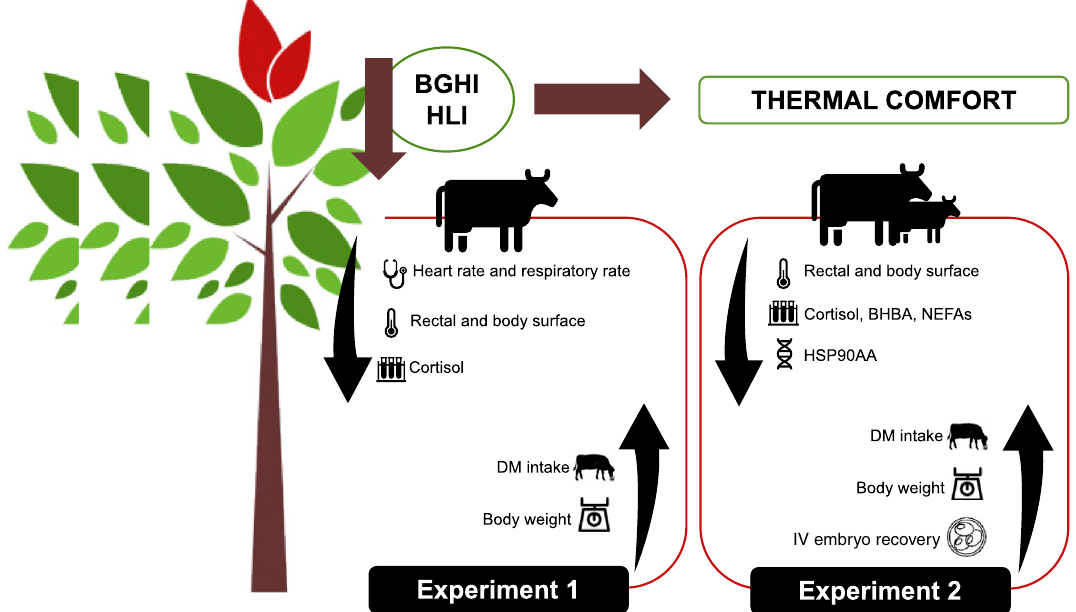
Figure 1. Hypothetical model. Natural shade in pasture areas improves the thermal comfort of beef heifers and beef cows due to both reduced black globe humidity index (BGHI) and heat load index (HLI). It consequently determines reduction in heart rate, respiratory rate, rectal and body surface temperatures, cortisol, heat shock proteins expression (HSP90AA) and increases dry matter intake (DMI), body weight, and in vitro embryo recovery. BHBA β-hydroxybutyrate, NEFAs non-esterified fatty